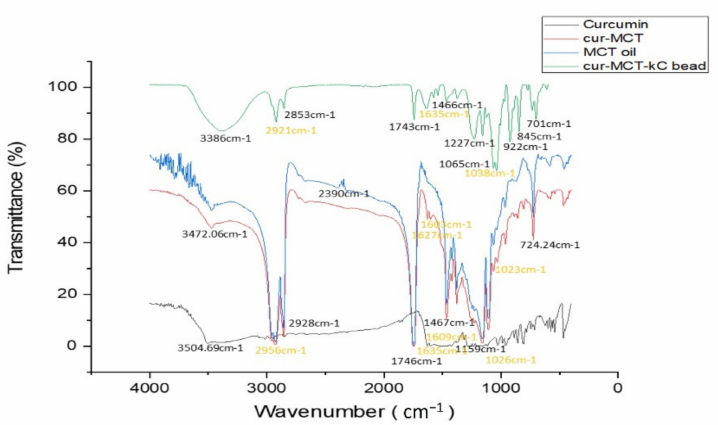
Figure 5. The FTIR spectra of the prepared CUR-MCT-KC, CUR, MCT oil, and KC in the range of 400–4000 cm − 1 at a 4 cm − 1 resolution. The yellow wavelengths indicated the successful CUR encapsulation whereby most of the active functional groups of CUR have been introduced in MCT as well as in the final formation of